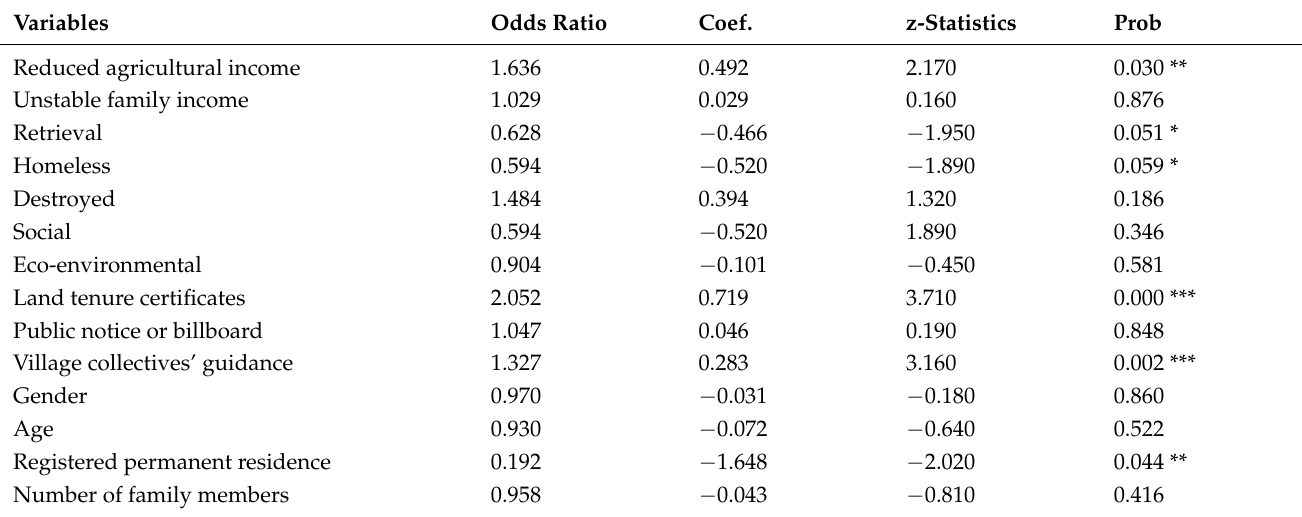
Table 3. Significant variable regression results of ordered logistic